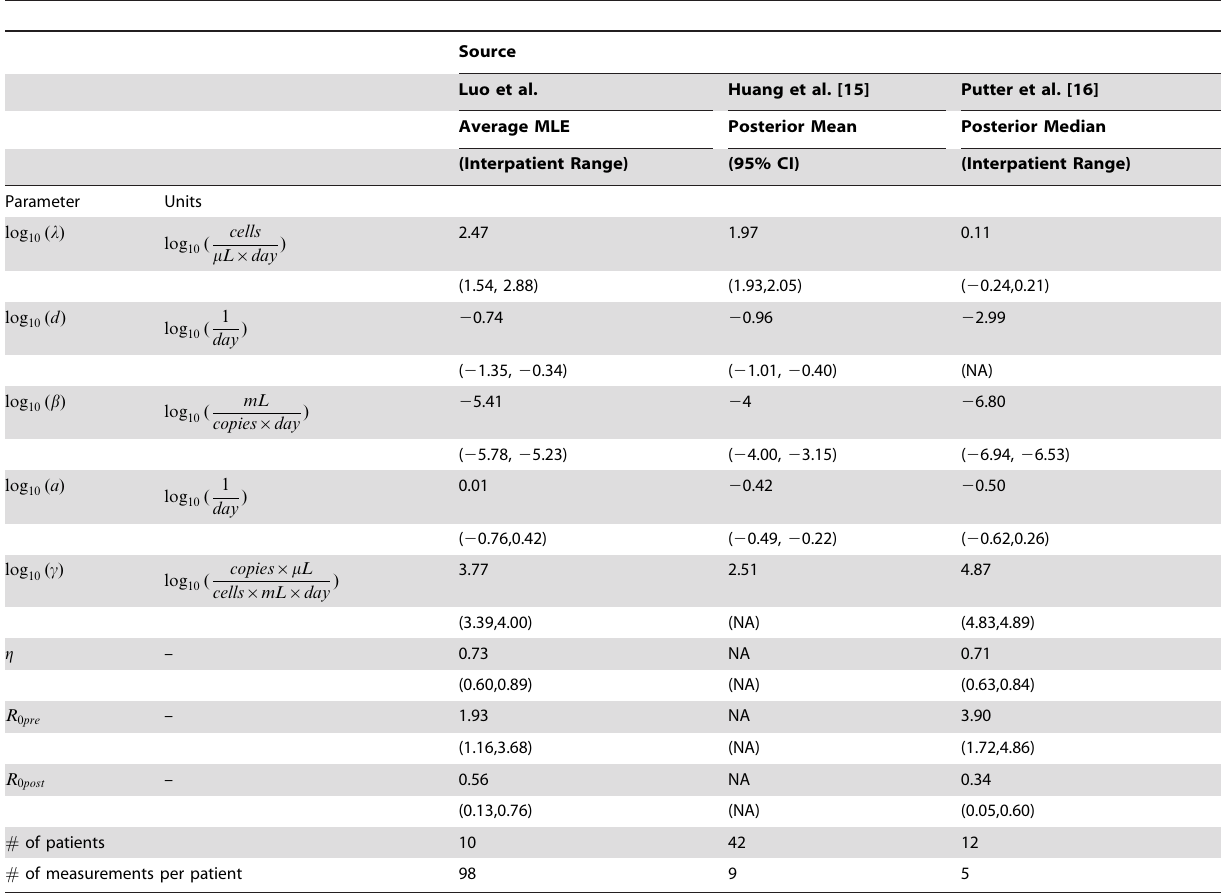
Table 3. Result comparison between this paper and previous studies.